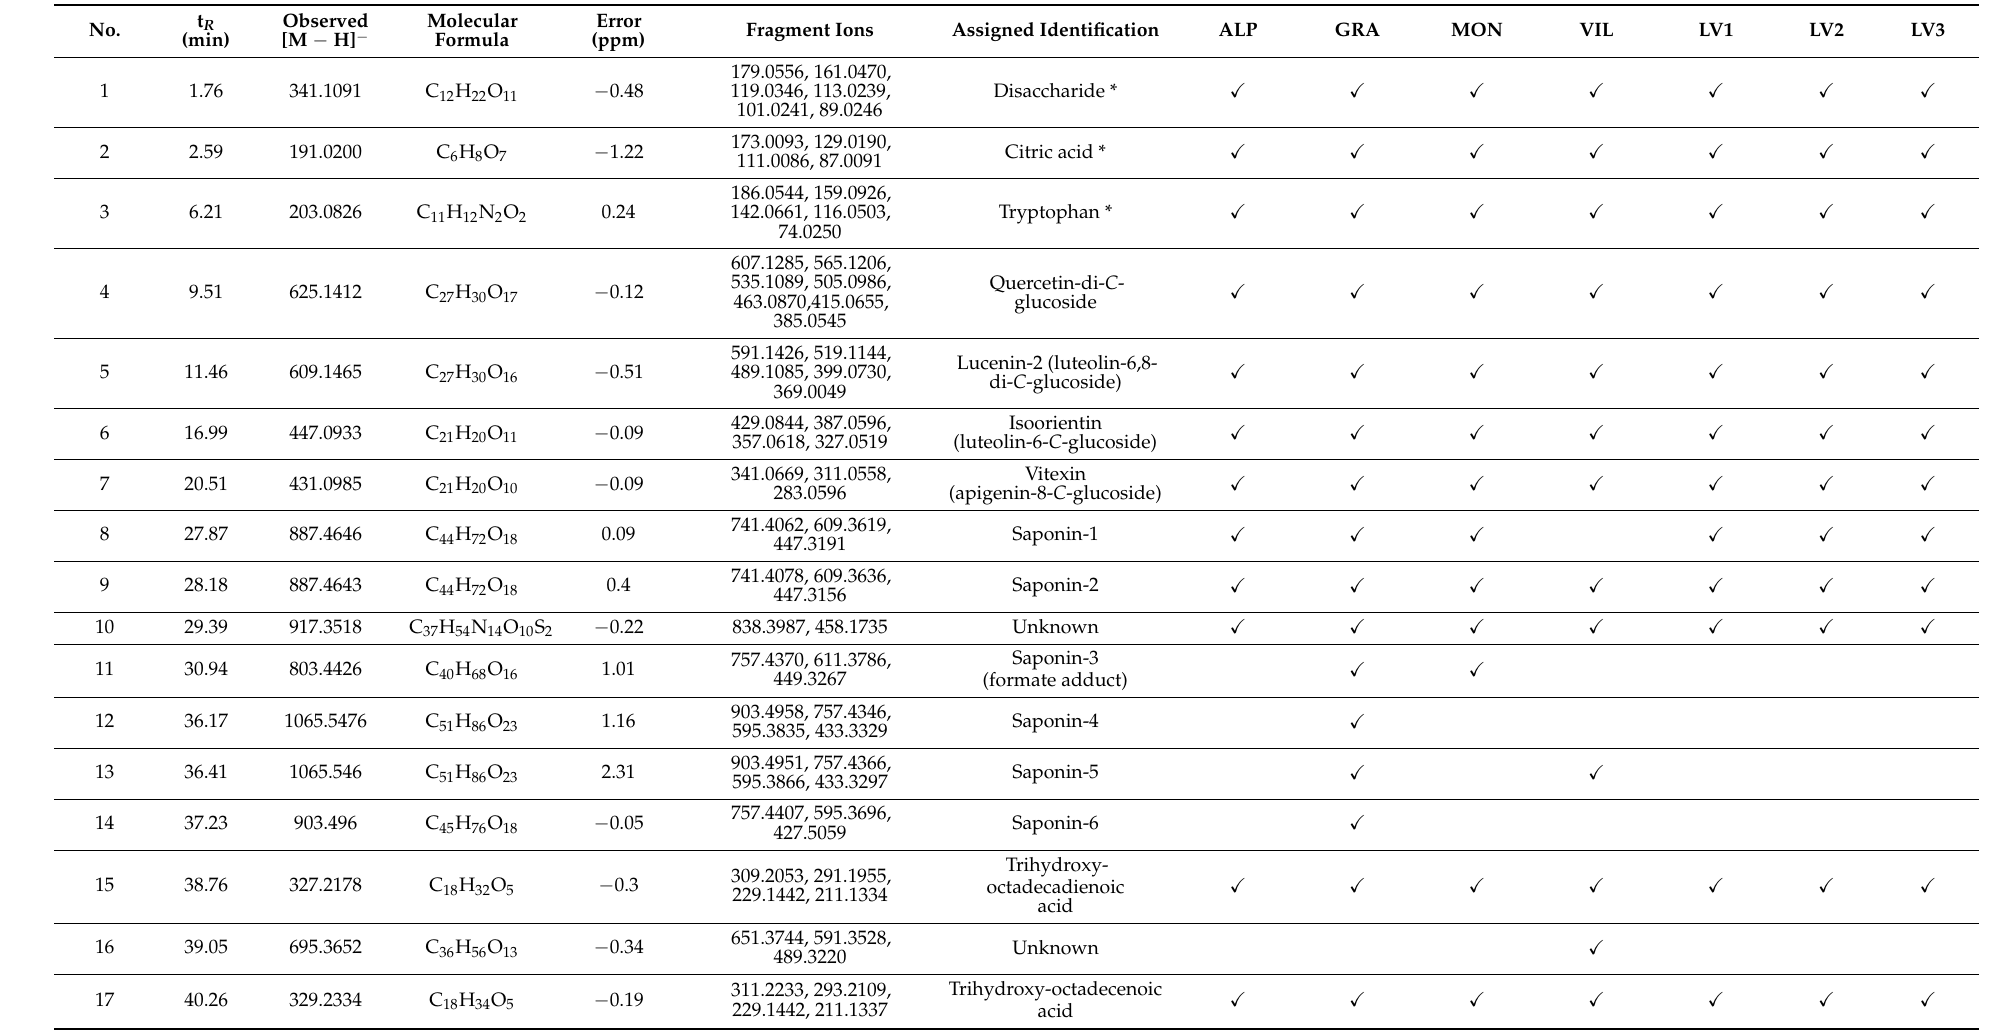
Table 2. Characterization of the compounds found in the analyzed extracts of C. reverchonii